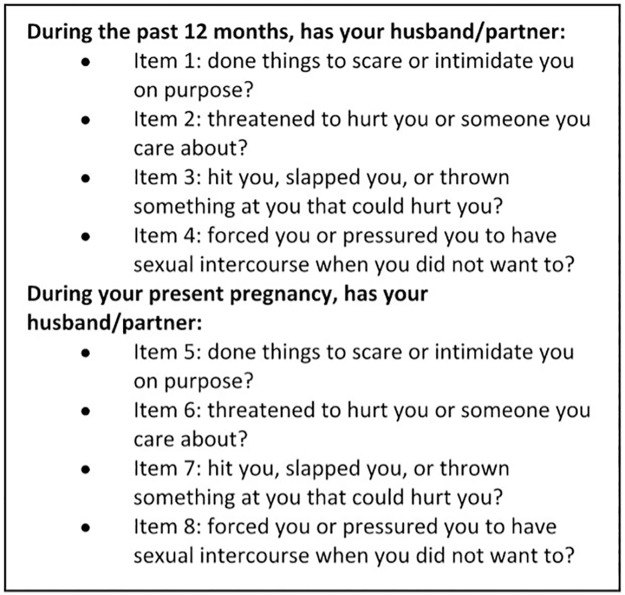
Screening questions.